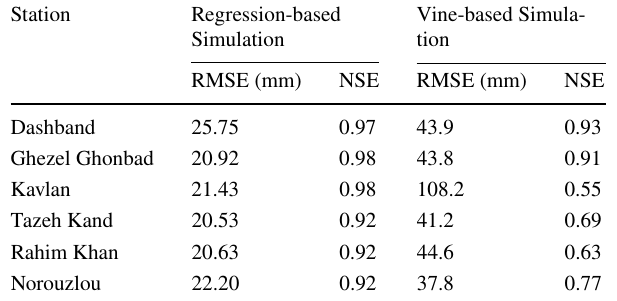
Table 7 The results of the N(i) index concerning the rating of the rain-gauge stations in the Siminehrood